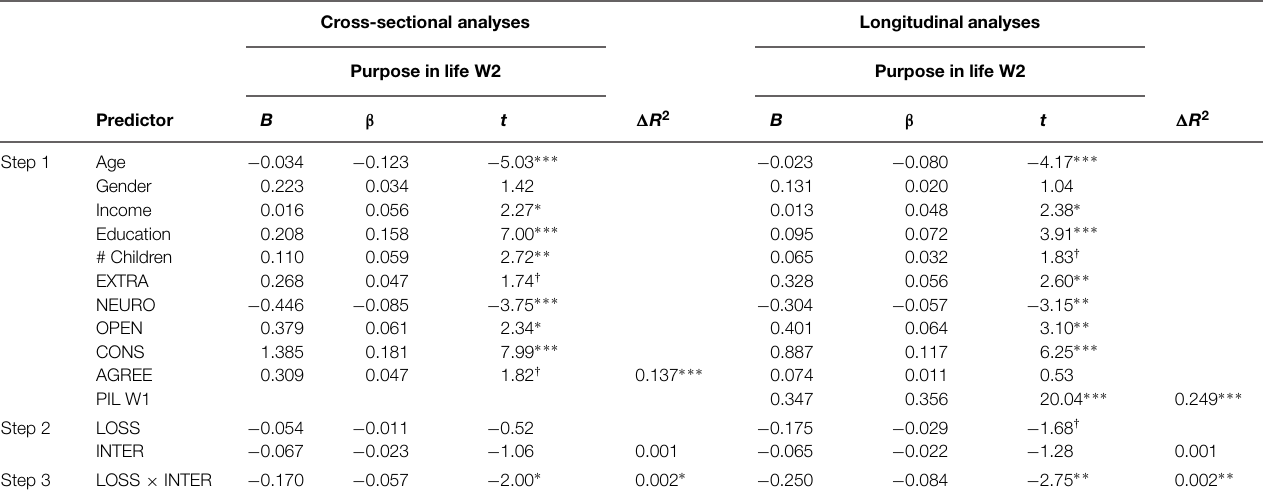
TABLE 2 | Cross-sectional and longitudinal